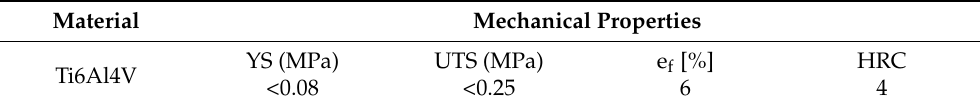
Table 2. Mechanical properties of Ti6Al4V: yield strength (YS); ultimate tensile strength (UTS); elongation at fracture (e f ); HRC: Rockwell C hardness.